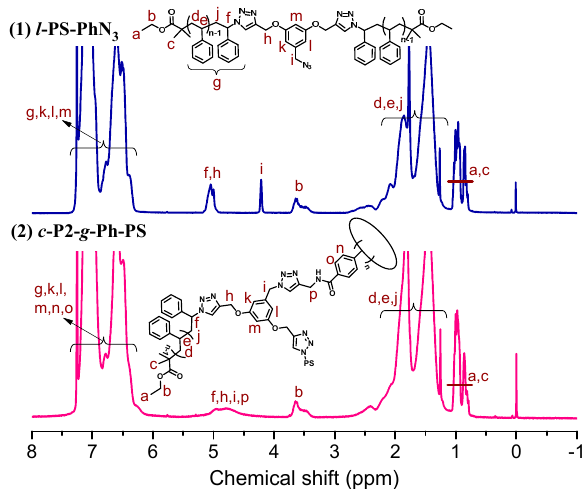
Figure 5. 1 H NMR spectra of l -PS-PhN 3 and c -P2- g -Ph-PS in CDCl 3 .